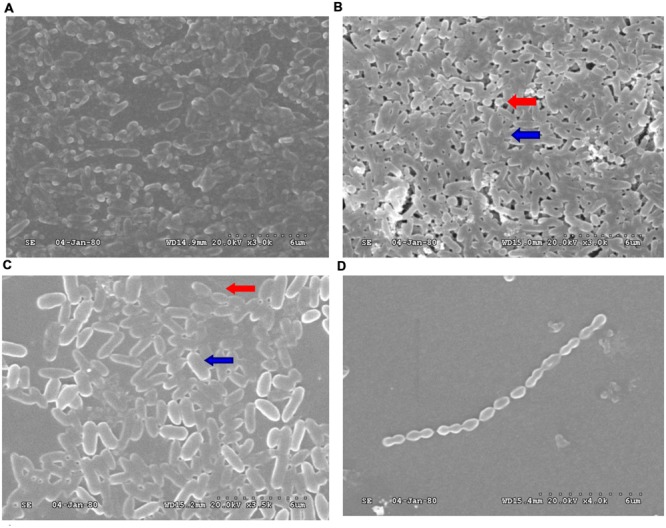
Scanning electron microscopy (SEM) analysis of biofilms obtained from PAO1 and Streptococcus mitis. (A) PAO1 mono-culture. (B) PAO1 and S. mitis co-culture. (C) PAO1 and S. mitis co-culture with 50 mM D-ribose. (D)
S. mitis mono-culture. Red arrows: S. mitis; Blue arrows: PAO1.